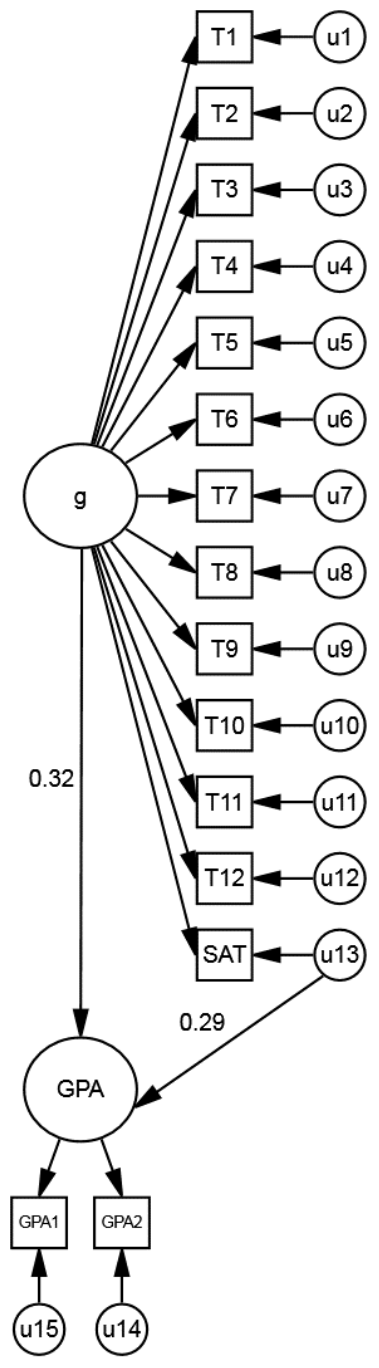
Figure 1 . Model of g with the SAT, ASVAB tests (T1–T12), and college GPA. A parallel model (not shown) analyzed the ACT. The symbol “u13” represents the non- g residuals of SAT composite scores (math + verbal), obtained after removing g . The u13 → GPA path estimates the relation of the SAT non- g residuals with GPA (β = 0.29). Figure adapted from Coyle and Pillow [6].